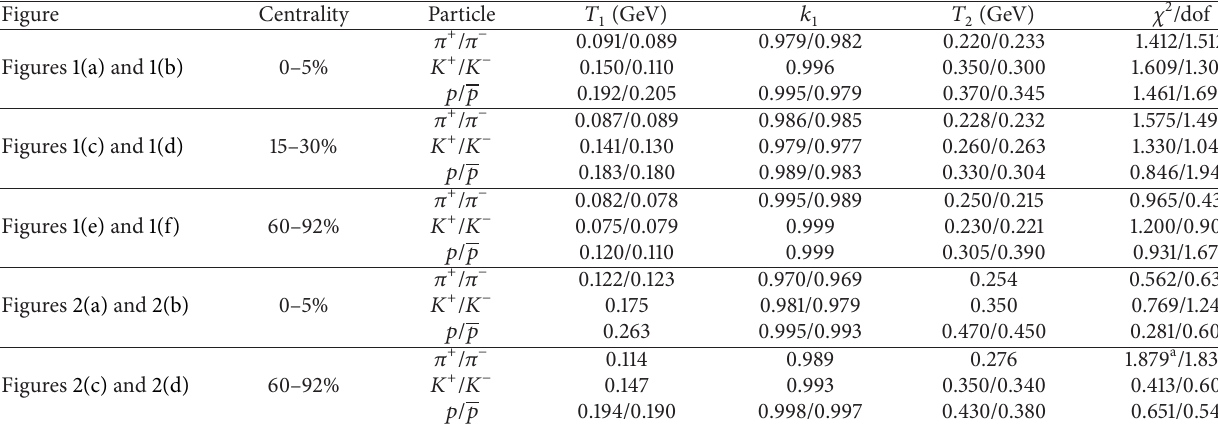
Table 1: Parameter values corresponding to the curves in Figures 1 and 2 for Au-Au collisions at √𝑠 𝑁𝑁 = 130 and 200 GeV, respectively. The values for positively/negatively charged particles are given in terms of “the first value/the second value” in the case of the two values being different. The relative errors estimated for 𝑇 1,2 and 𝑘 1 are less than 6% and 0.5%, respectively.